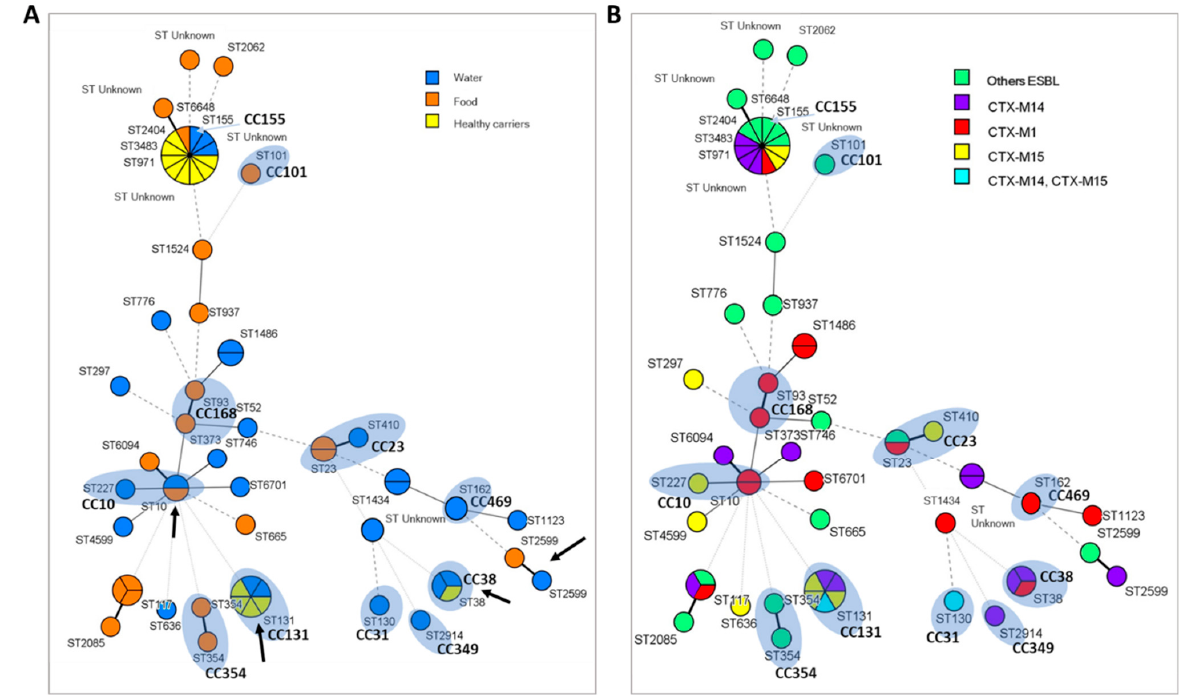
Figure 4. Clonal composition by MST of the 61 E. coli strains analyzed according to the source of isolation ( A ) and in relation to the type of β -lactamase produced ( B ). Each circle corresponds to an ST; its size being proportional to the number of isolates. The shaded areas indicate the detected CCs that group different STs. The union lines between the different nodes (bold, continuous, dashed or dotted lines) show the number of discordant alleles between the profiles of the strains (1, 2, 3 and 4 alleles, respectively) and the arrows indicate the same ST that appear in different niches.